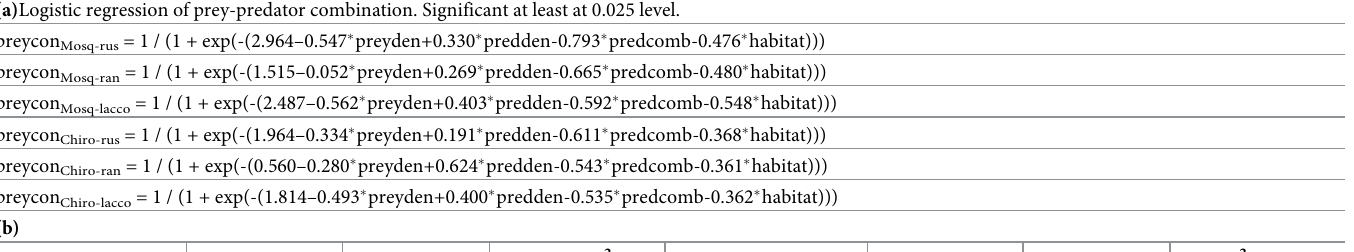
Table 1. (a) The logistic regression equations representing the variations in the shared prey consumed (preycon) by the IG predators against the prey density (prey- den), predator density (predden) and predator combination (predcomb) and habitat complexity (habitat) as explanatory variables. Predator combinations were (i) only IG prey and shared prey ii) both IG predator and IG prey with shared prey iii) only IG predator and shared prey. The level of significance assumed to be 0.025. The prey and predator combinations are shown in the suffix. (b) Significant values of the parameters of the model (in bold) were deduced through the Wald’s Chi-square test represented below. Here, the prey predator combinations were, mosq–Mosquito larvae, rus– D . rusticus , Chiro–chironomid larvae, ran- R . filiformis , lacco– L . griseus . (a) Logistic regression of prey-predator combination. Significant at least at 0.025